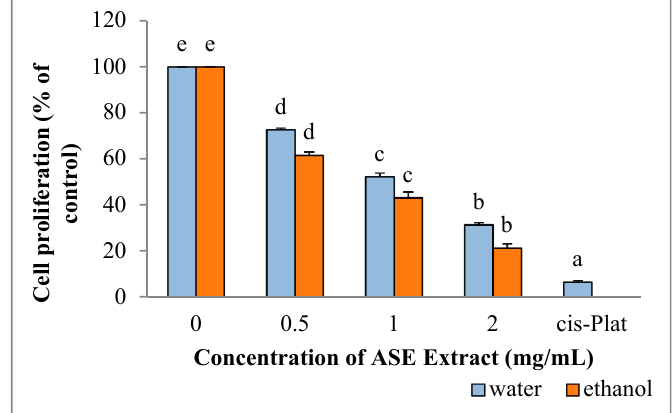
Figure 2. Effect of ASE crude extracts on of HepG2 cell proliferation. Each value is expressed as mean ± SD, n = 3 (untreated group: concentration = 0). Bars marked by unlike letters within a group are significantly different at p < 0.05, according to Duncan’s Multiple Range Test (DMRT).